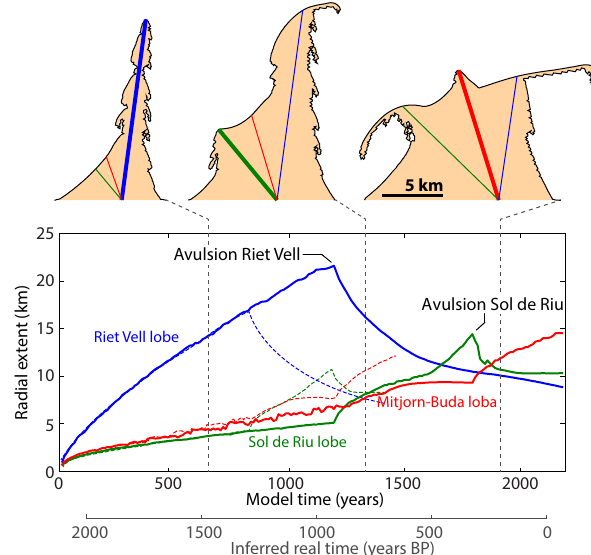
Figure 8. Simulated radial extent of the three different Ebro Delta lobes for a sediment supply of 70kgs − 1 and forced avulsions af- ter 1200 and 1800 model years (solid lines) and after 800 and 1200 model years (dashed lines). Note that the radial extent can increase without the lobe being active because of littoral sediment trans- ported from adjacent lobes. Three inset deltas show the solid line model run after 700, 1350, and 1900 years. The gray second hori- zontal axis indicates the real time inferred from the solid line model run and the modern Ebro Delta morphology, where, at the year 2015, lobes 1 and 2 are approximately 10km long, and the active lobe is 15km long, measured from the apex (Fig.